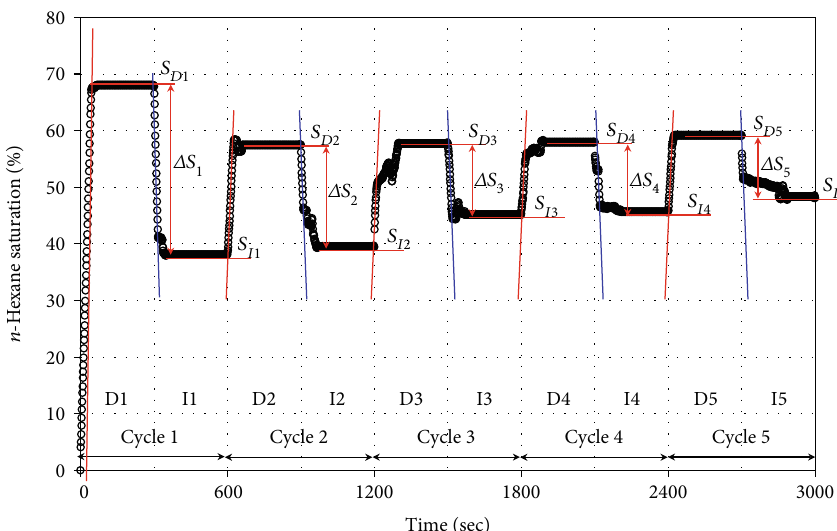
Figure 6: Evolution of hexane saturation throughout the fi ve injection cycles. D: drainage, period of hexane injection; I: imbibition, period of deionized water injection. Since the micromodel is always fully saturated with hexane and deionized water, water saturation can be estimated as the complement of hexane saturation.